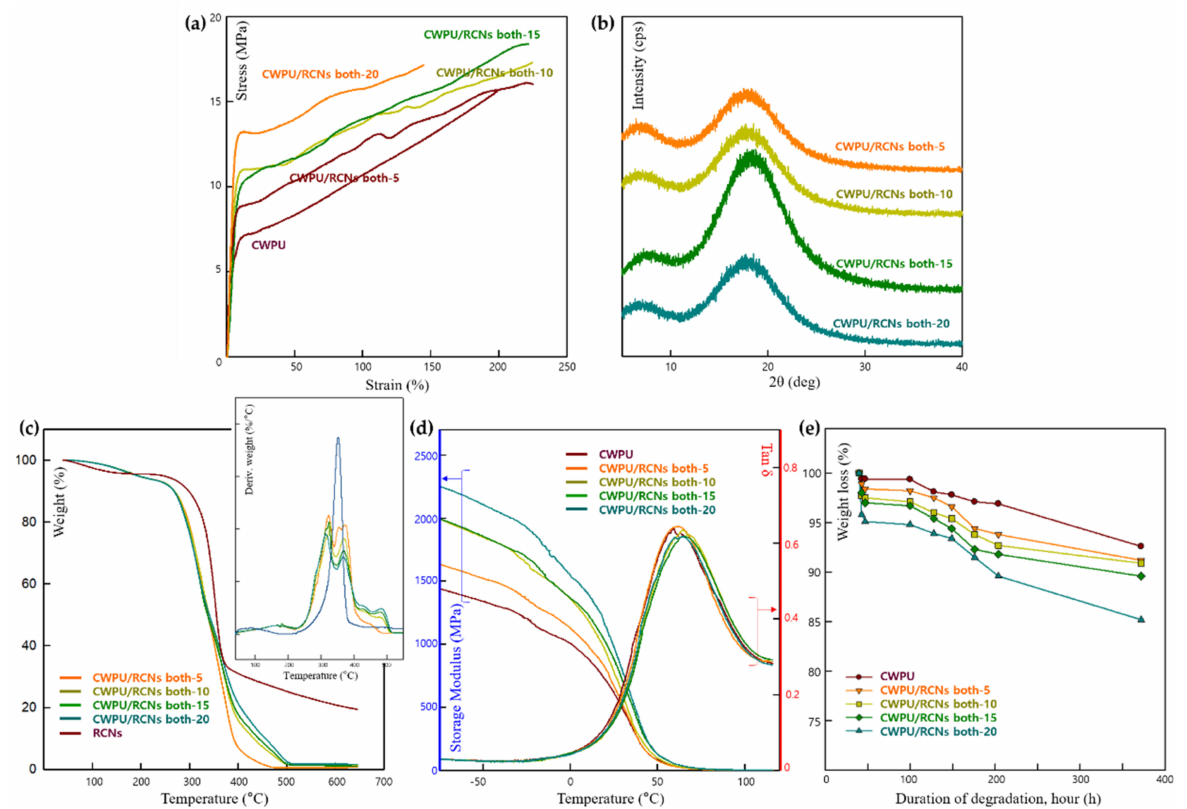
Figure 8. ( a ) Stress-strain curves, ( b ) XRD patterns, ( c ) TGA dynamic thermograms, ( d ) storage moduli and tan as a function of temperature, and ( e ) dependence of the weight loss as a function of time during the cellulase degradation of the CWPU and CWPU/RCNs nanocomposite films according to RCNs contents. Table 5. Young’s modulus, tensile strength, toughness, T g , and percentage elongation of CWPU